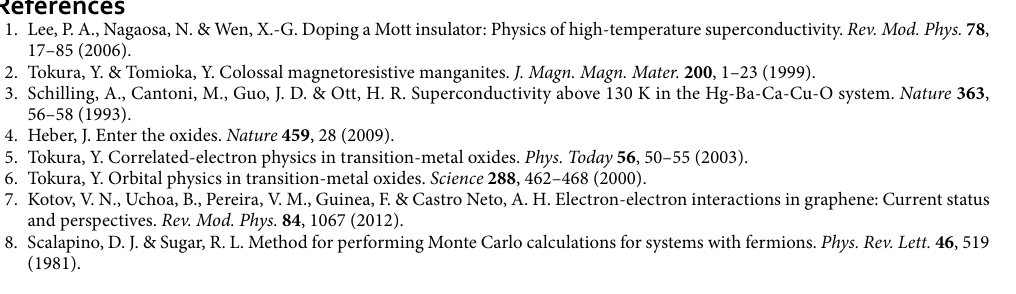
Figure 6. Shows beyond super cell approximation Nc u 0.6 t , 1 t . For u > 0.6 t a semi metal to anti ferromagnetic phase transition occur. dos obtained from realistic = bands with dos obtained from calculated local Green function